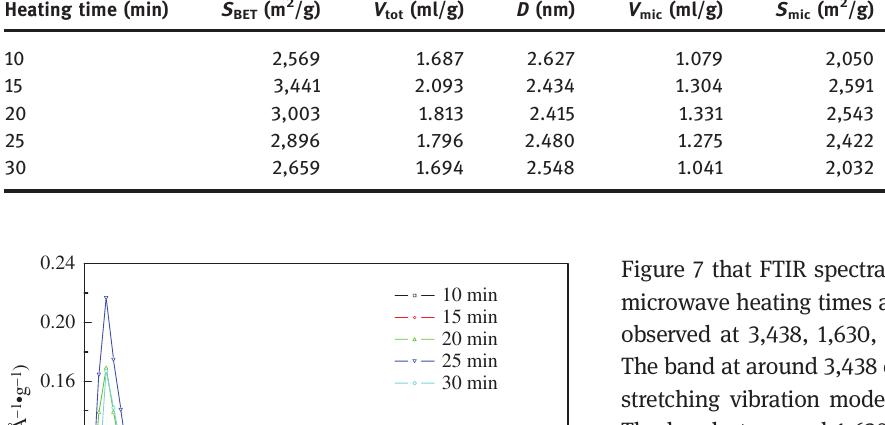
Table 2: Details of pore structure of activated carbon with different microwave heating times. Heating time (min)